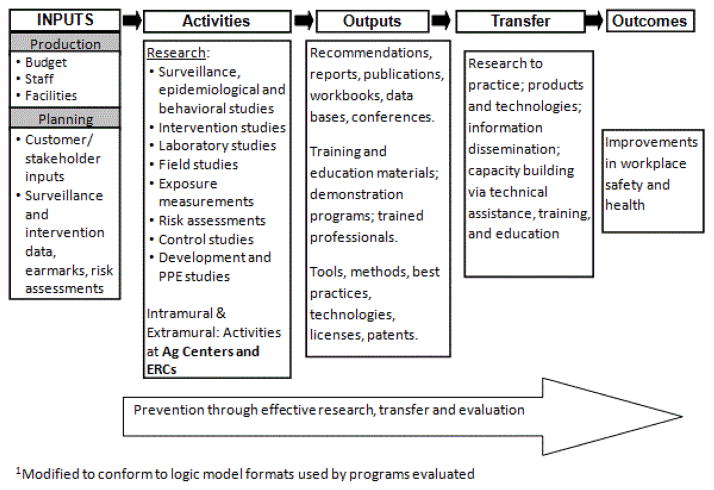
NIOSH logic model.